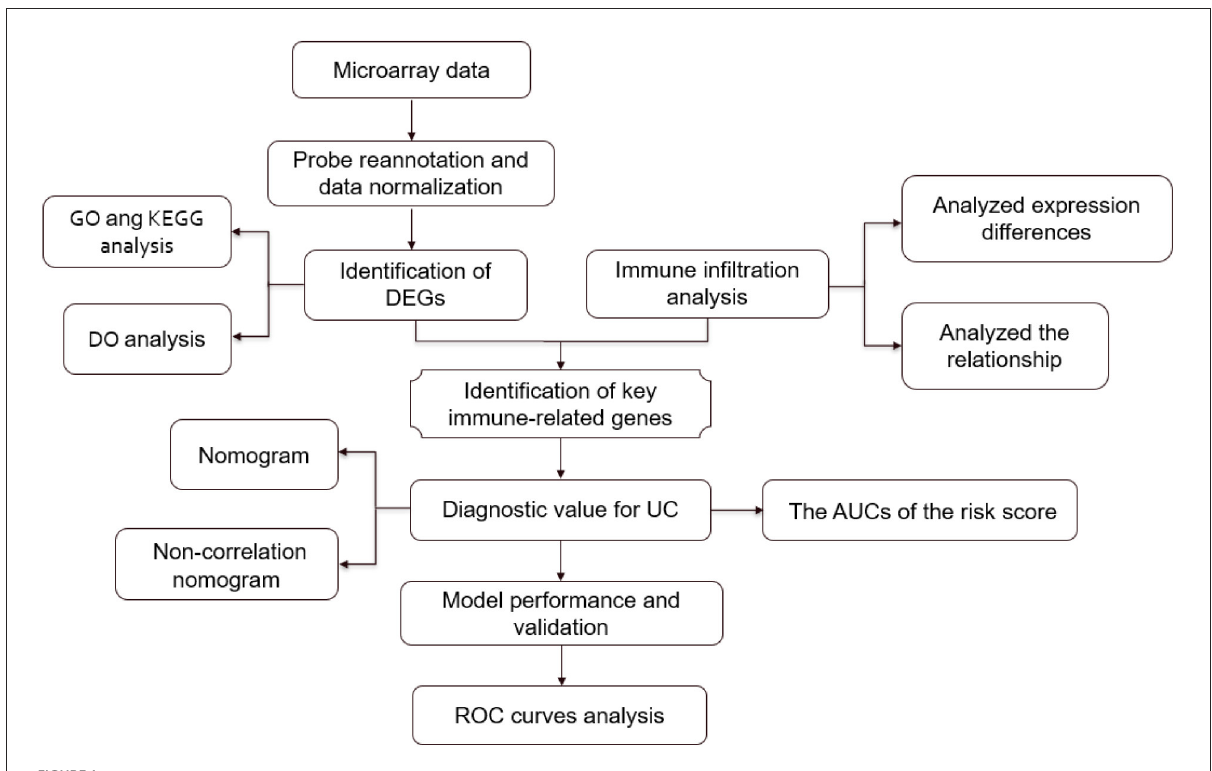
FIGURE1 Flowchart of the present